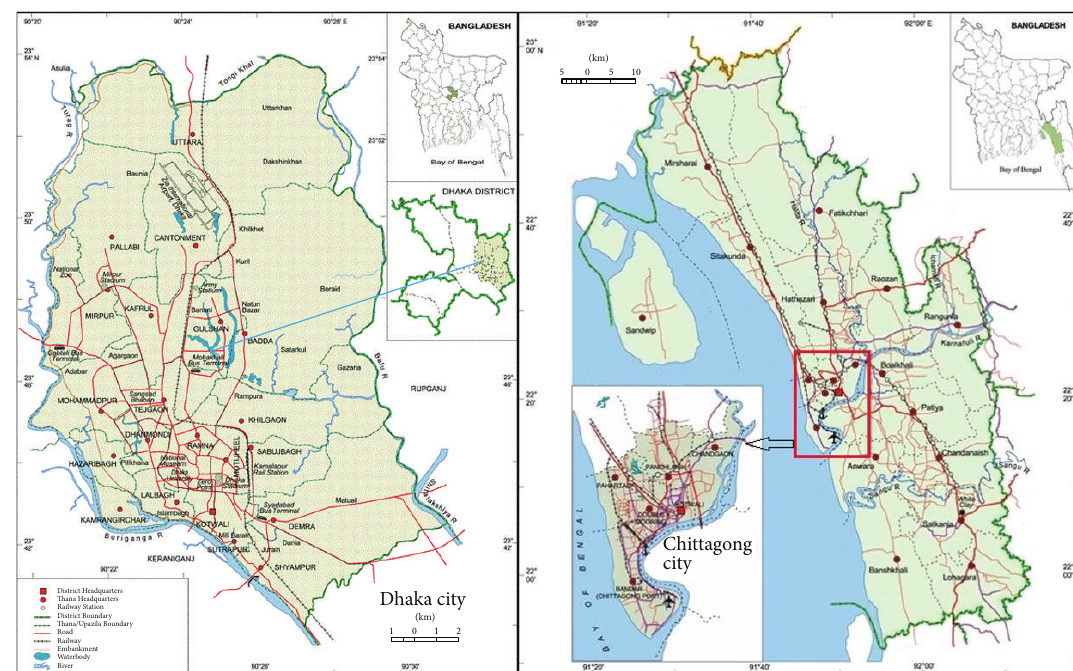
Figure 3: Generalized map of the studied city of Bangladesh and its location in Bangladesh.